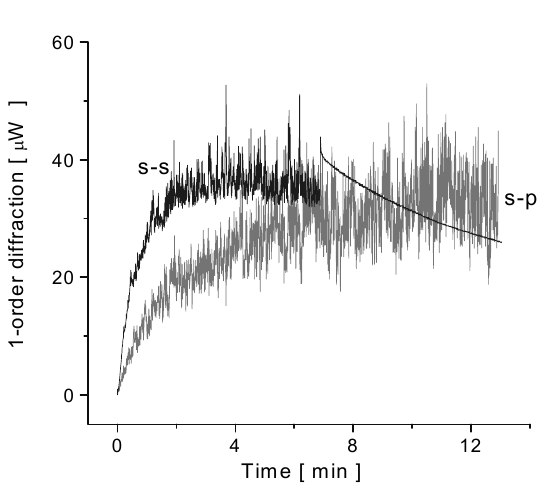
Fig. 4 An example of kinetics of grating recording in poly(ester-imide) (1c) for s − p and s − s polarization recording. For the s − s polarization the noise free line starting at 7 min shows the grating erasure process i.e. light diffraction when only a single beam is